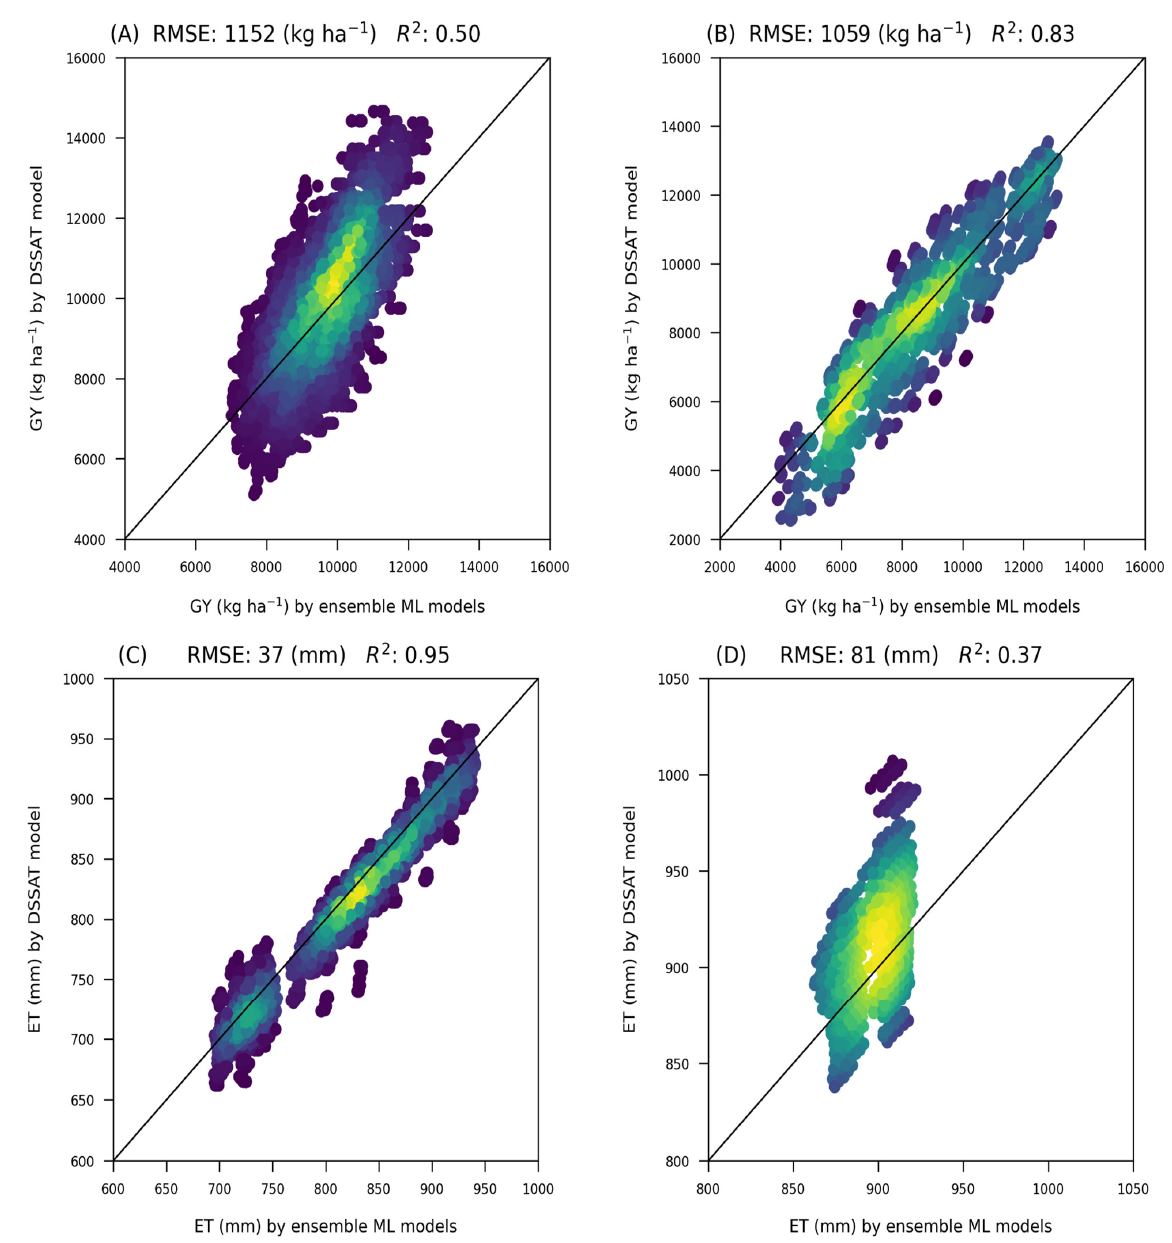
Figure 4. ( A ) Maize GY (kg ha − 1 ) by DSSAT vs. ensemble ML models in response to varying the management variables shown in Table 2 and keeping the environmental variables constant with the soil profile of GIZA site; ( B ) maize GY (kg/ha) by DSSAT vs. ensemble ML models in response to varying the environmental variables while keeping the management variables constant at the recommended practice; ( C ) seasonal ET (mm) by DSSAT vs. ensemble ML models in response to varying the management variables; and ( D ) seasonal ET (mm) by DSSAT vs. ensemble ML models in response to varying the environmental variables. The DSSAT model and ML models were compared at a fifth independent location (Sharqia) than those used in the model calibration and evaluation (five locations). Yellowish regions indicate higher